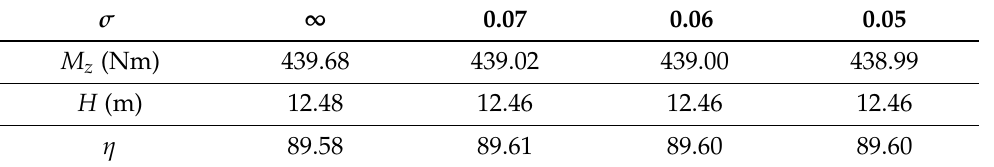
Table 3. Effect of cavitation number on the torque, M z , head, H , and efficiency η